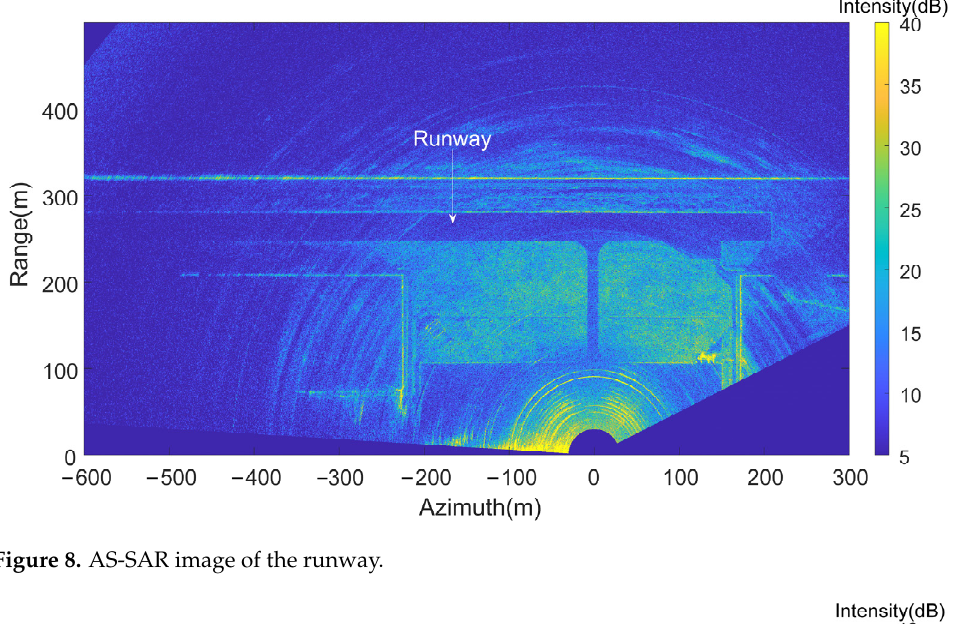
Figure 7. AS-SAR and its working field scene.